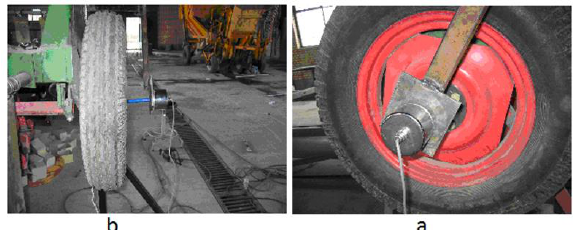
Figure 9. Different views of the encoder mounted on the Seed drill